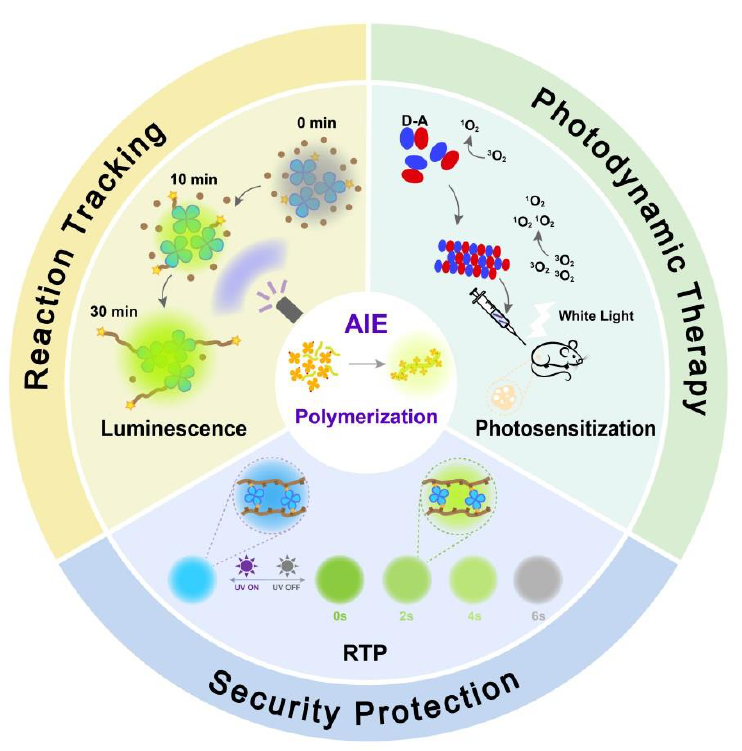
Figure 1. The schematic diagram of the representative polymerization-enhanced photophysical properties and applications